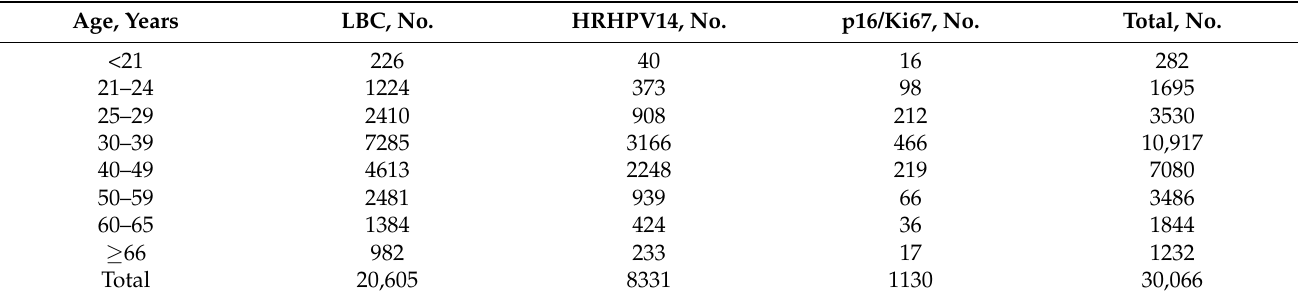
Table 4. Age-stratified LBS tests reporting